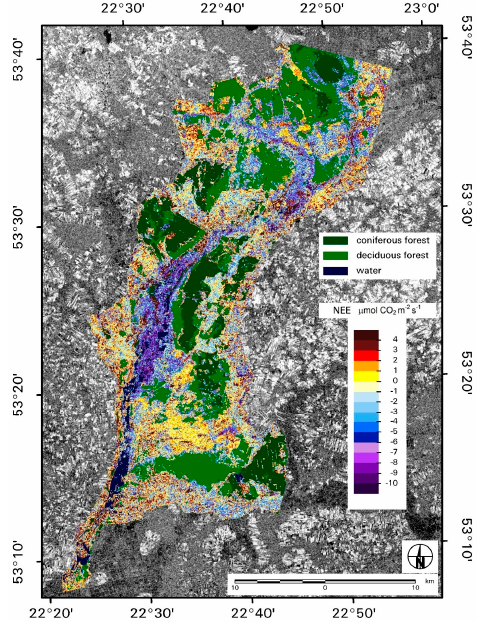
Figure 13. Map of NEE distribution over Biebrza wetland on 10 July 2015.